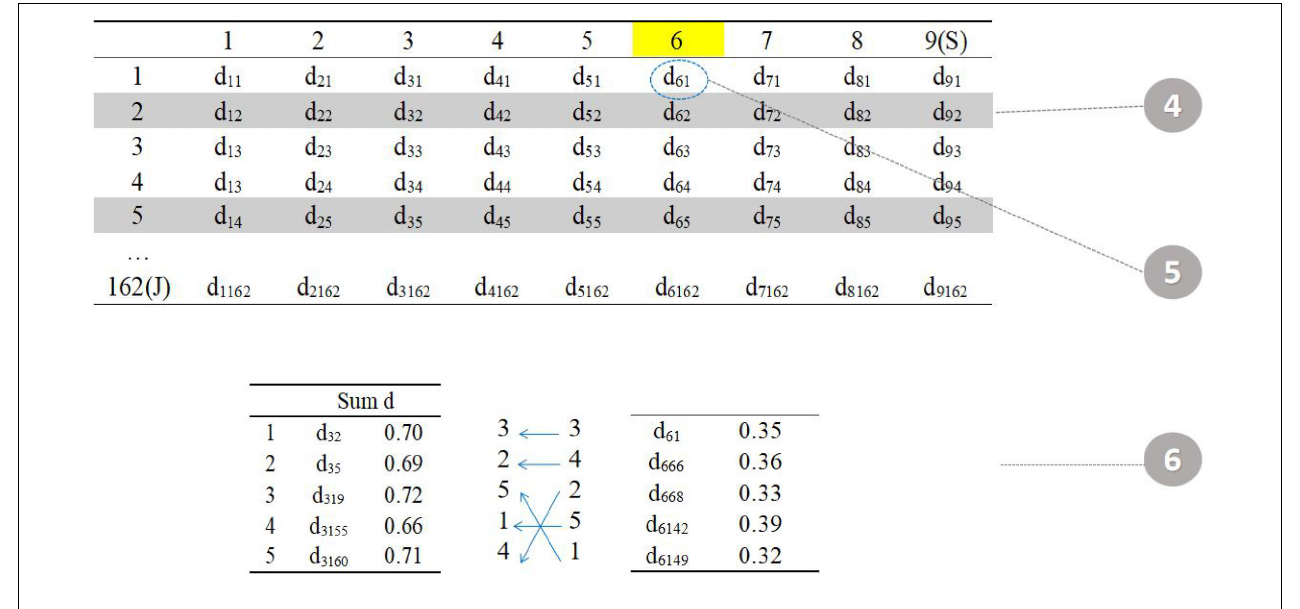
FIGURE 4 | Procedure 4–5.